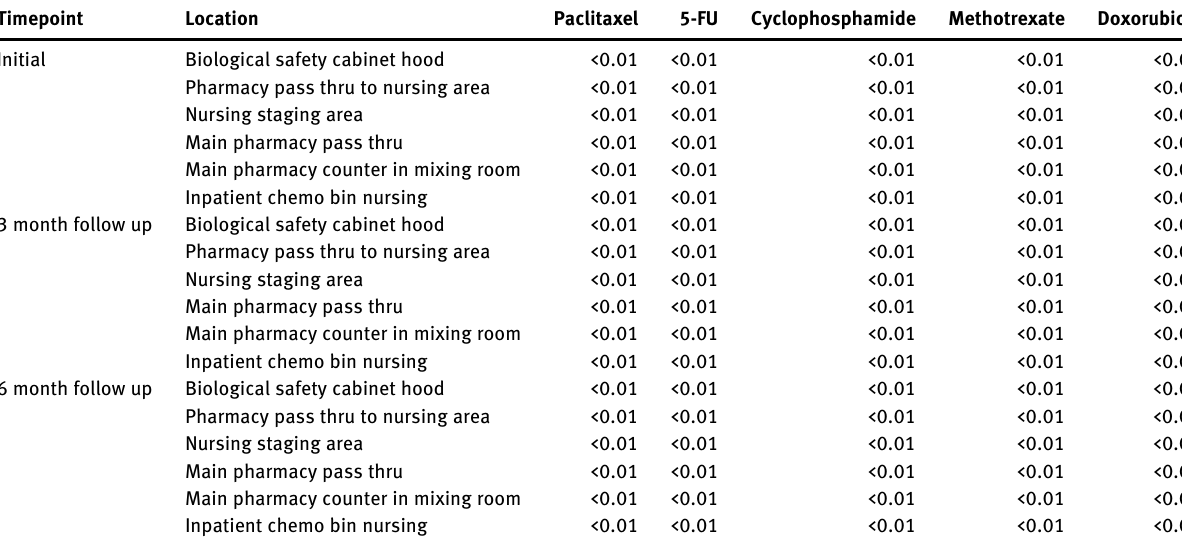
Table  : Initial,  month, and  month surface contamination wipe analysis (ng/cm  ). Timepoint Location Paclitaxel  -FU Initial